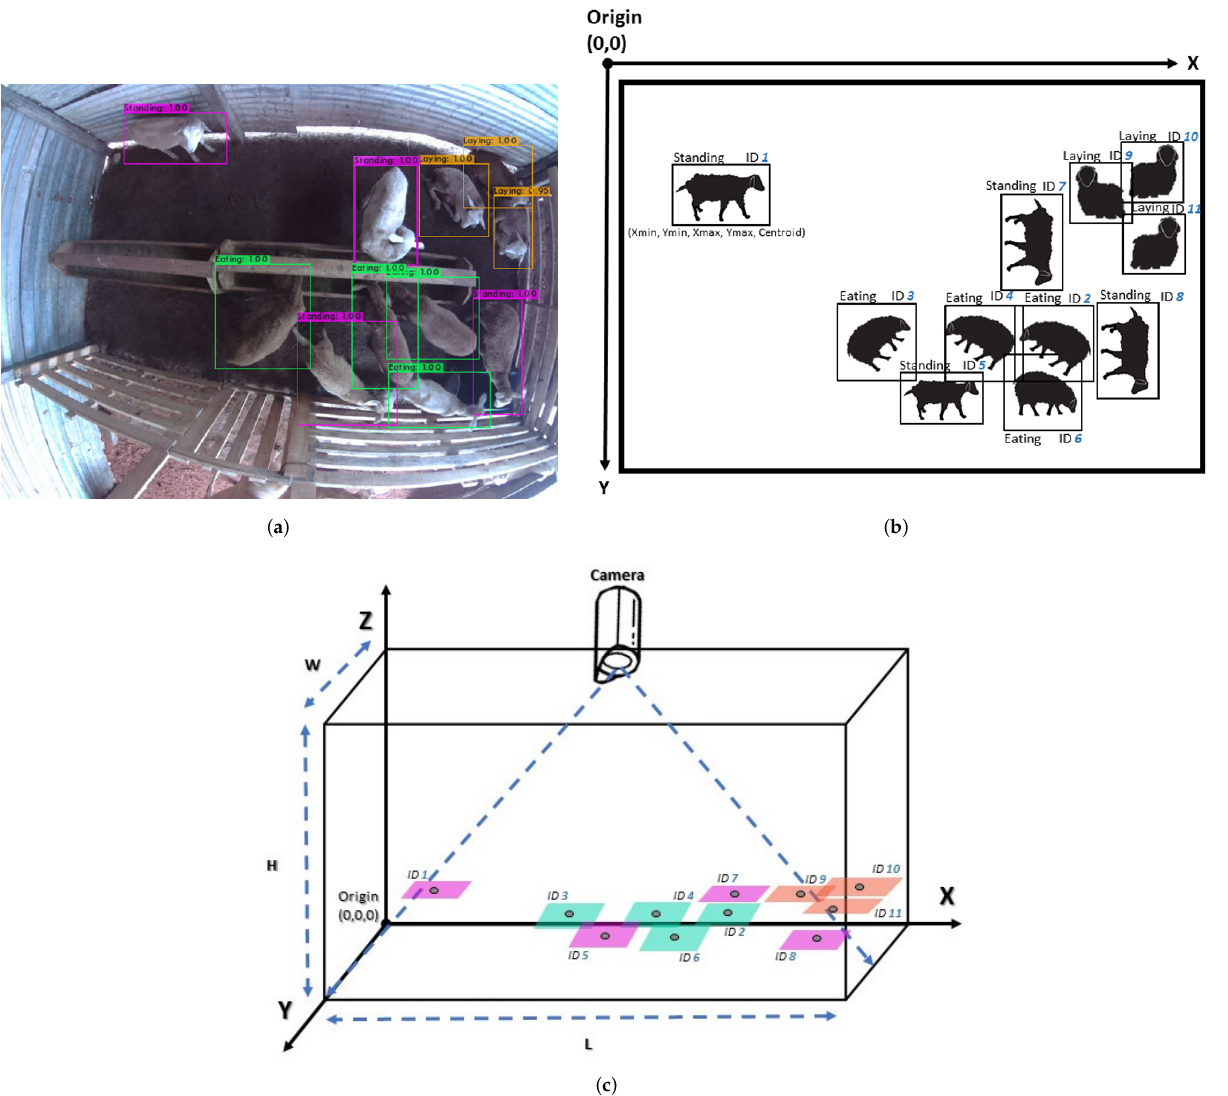
Figure 2. General distribution of the system for lamb detection. ( a ) Real scenario. ( b ) Plane coordinate system. ( c ) Distribution spatial system.